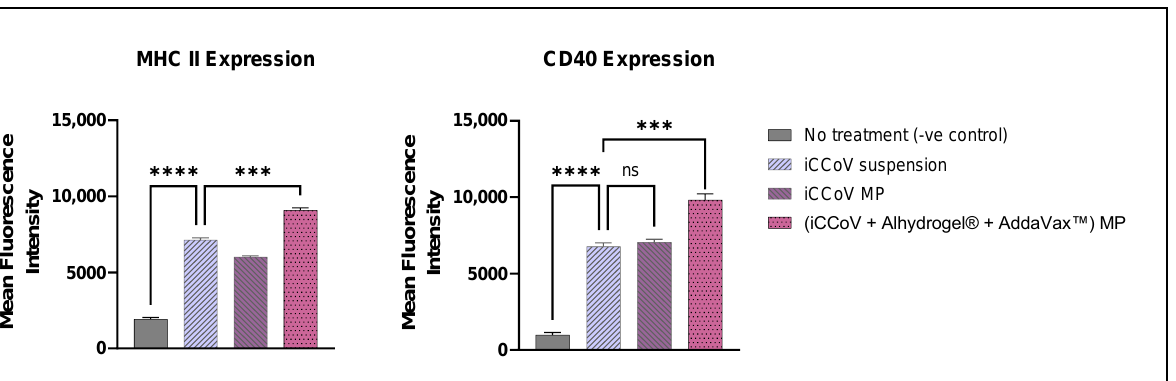
Figure 7. Expression of MHC II and CD40 on the surface of murine DCs pulsed with various groups. Cells were plated at a density of 3 × 10 4 cells/well. The cells were exposed to the following treatment groups for 24 h: No Treatment (- ve control), iCCoV suspension (2 μg), iCCoV MP (2 μg), and iCCoV MP (2 μg) + Alhydrogel ® MP (3 μg) + AddaVax™ (0.5 μg) MP. Data are expressed as Mean ± SEM ( n = 3), One-way ANOVA test, P ost hoc Dunnett’s multiple comparisons test, ns, non - significant, *** p ≤ 0.001, and **** p ≤ 0.0001 .